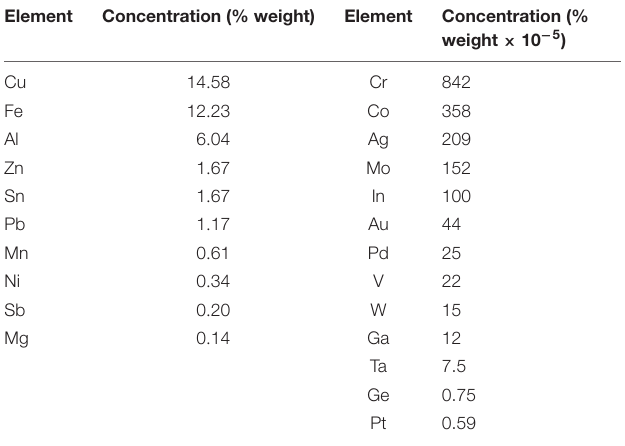
TABLE 1 | Element composition in % weight of low-grade PCB